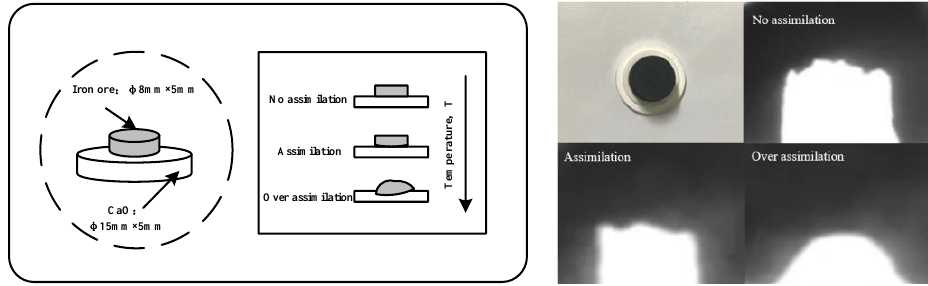
Figure 1. Schematic diagram of assimilation.